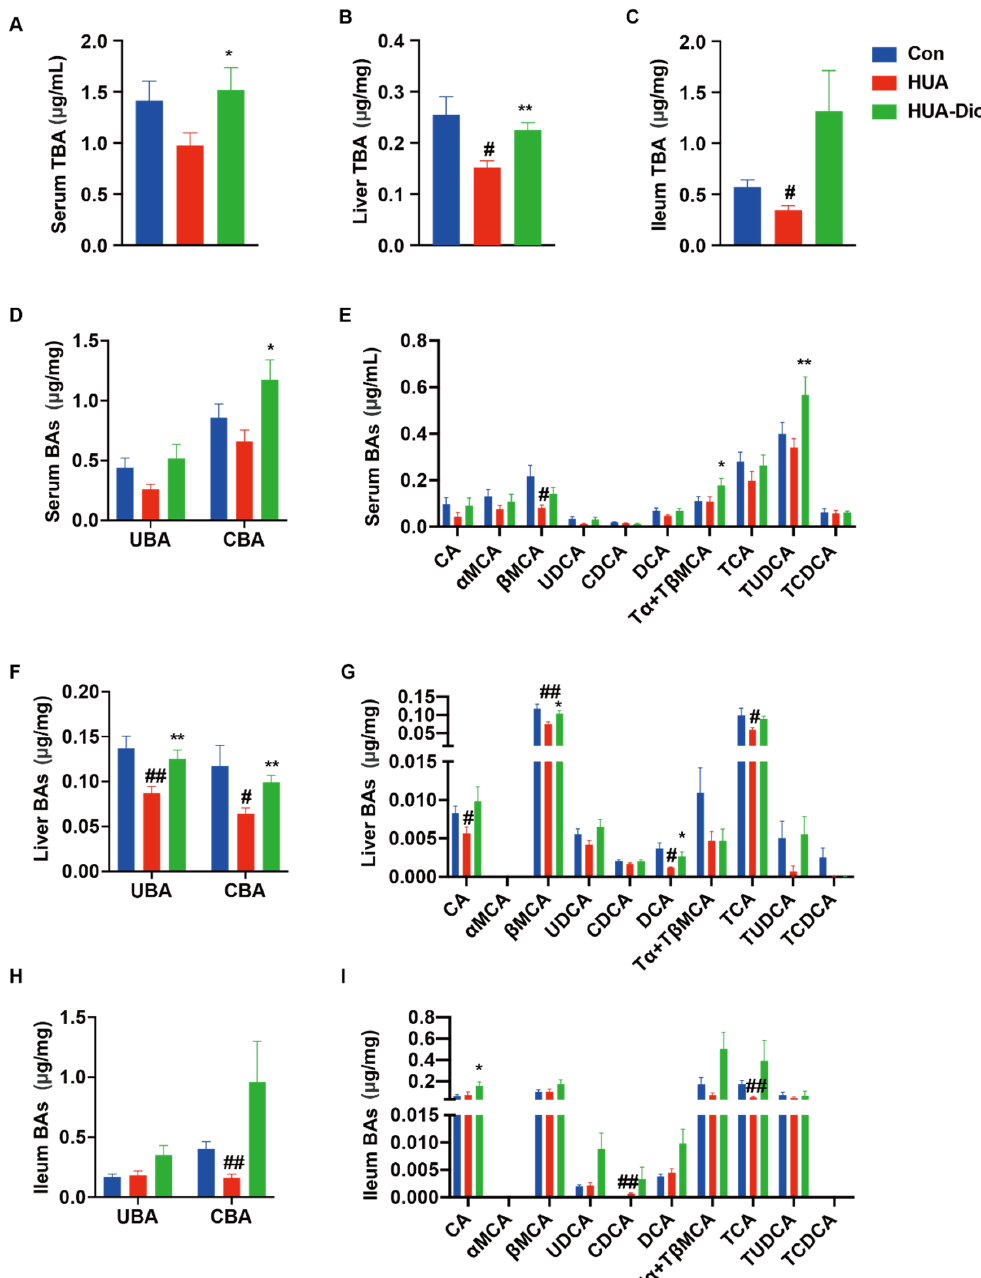
Figure 3. The effect of dioscin on the dysfunction of bile acid metabolism in hyperuricemic ApoE − / − mice. Control ApoE − / − mice group (Con), hyperuricemic ApoE − / − mice group (HUA), dioscin treatment hyperuricemic ApoE − / − mice group (HUA − Dio). ( A – C ) The levels of TBA in serum, liver, and ileum. ( D ) The levels of UBA and CBA in serum. ( E ) The bile acid profile in serum. ( F ) The levels of UBA and CBA in liver. ( G ) The bile acid profile in liver. ( H ) The levels of UBA and CBA in ileum. ( I ) The bile acid profile in ileum. Data are presented as mean ± S.E.M. # p < 0.05, ## p < 0.01 vs. control ApoE − / − mice group; * p < 0.05, ** p < 0.01 vs. hyperuricemic ApoE − / − mice group. We further detected the bile acid profile in different tissues. The contents of conju ‐ gated bile acids (TUDCA, TCA, TCDCA, T α MCA, and T β MCA), unconjugated bile acids (CA, α MCA, β MCA, UDCA, and CDCA), and secondary bile acids (DCA and LCA) were